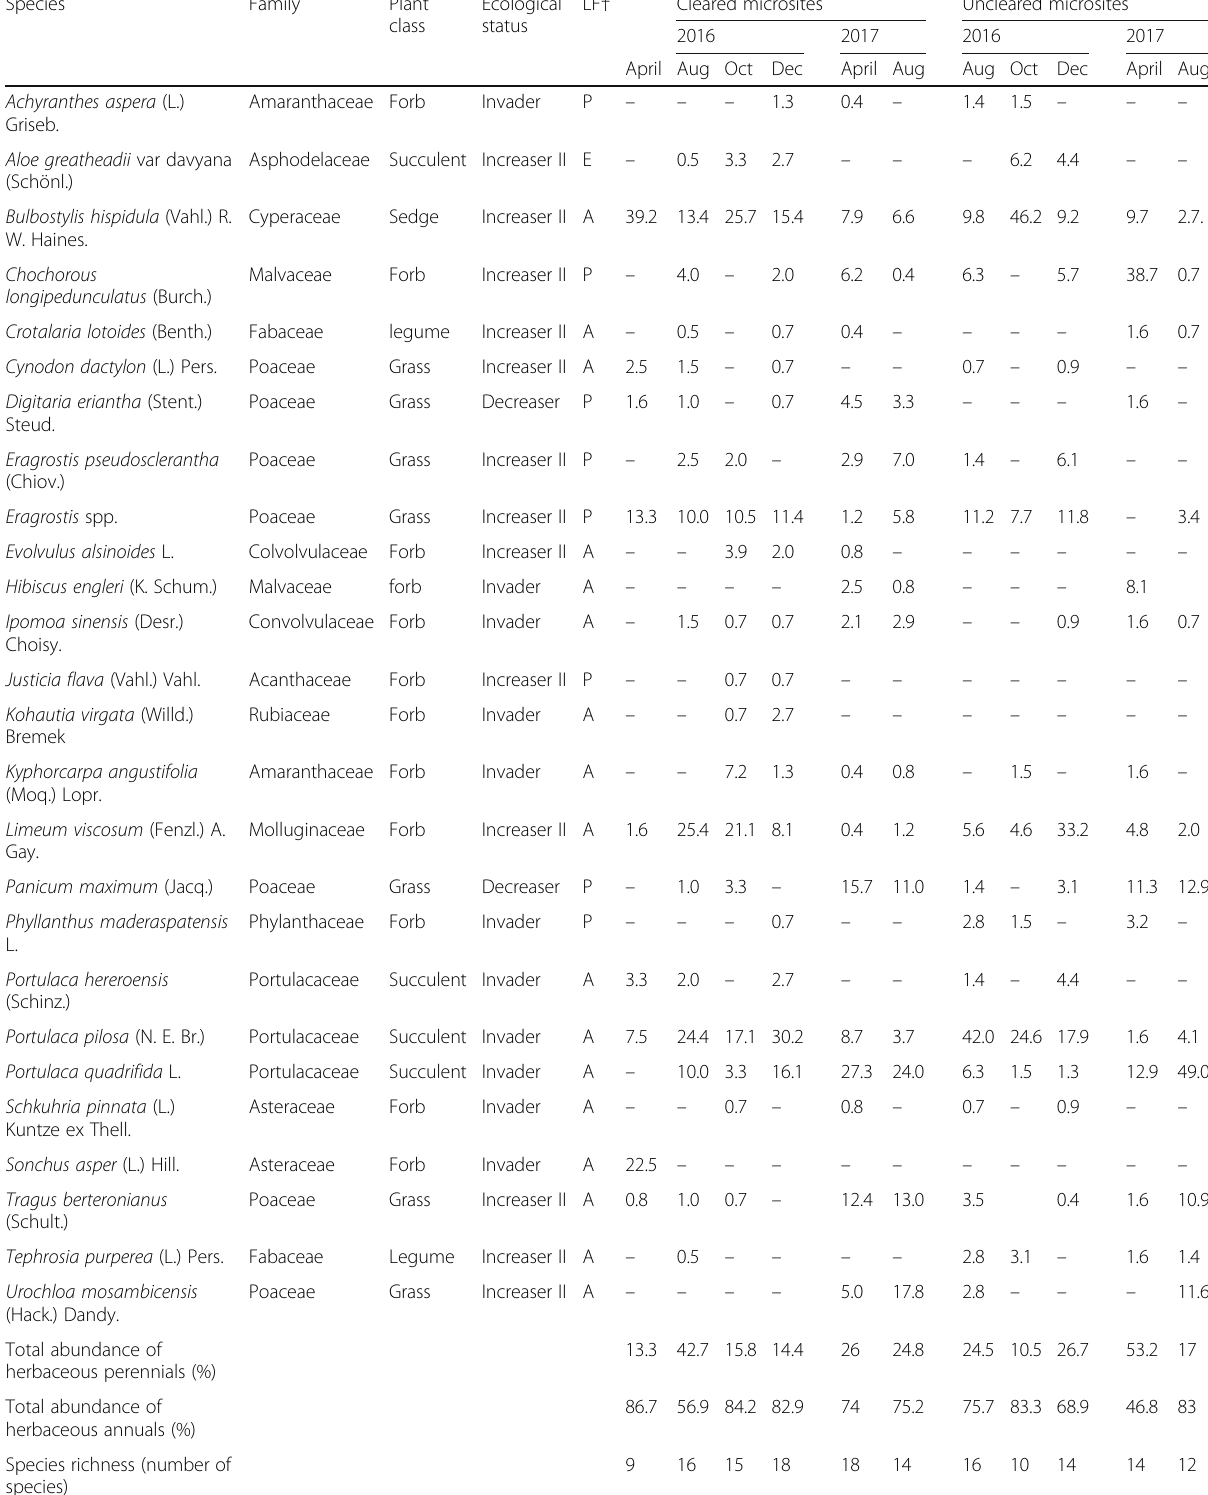
Table 2 Plant species abundance (%) of the soil seed bank over time in bush-cleared and uncleared microsites at Kgomokgomo from April 2016 to August 2017